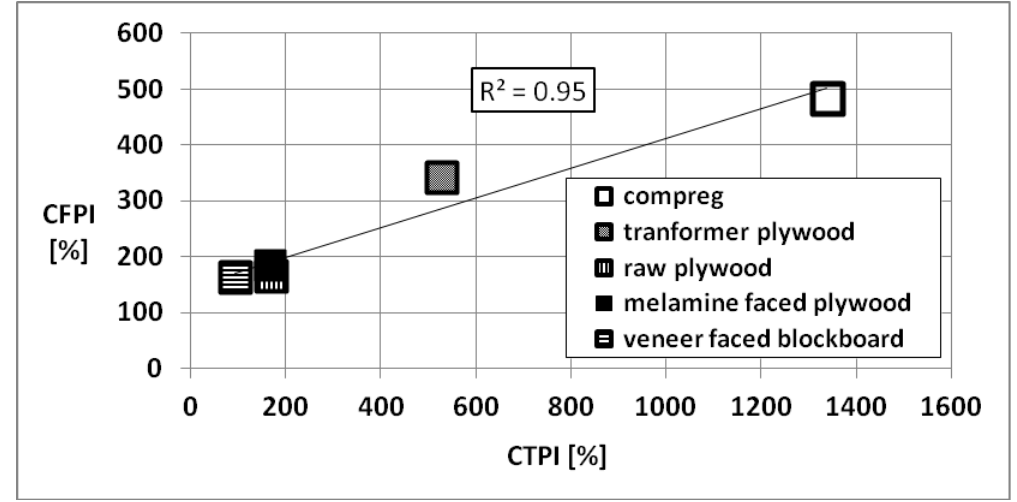
Figure 13. The relationship between significantly reliable (CFPI) and highly simplified (CTPI) machinability indexes which were determined for boards made of veneer or solid